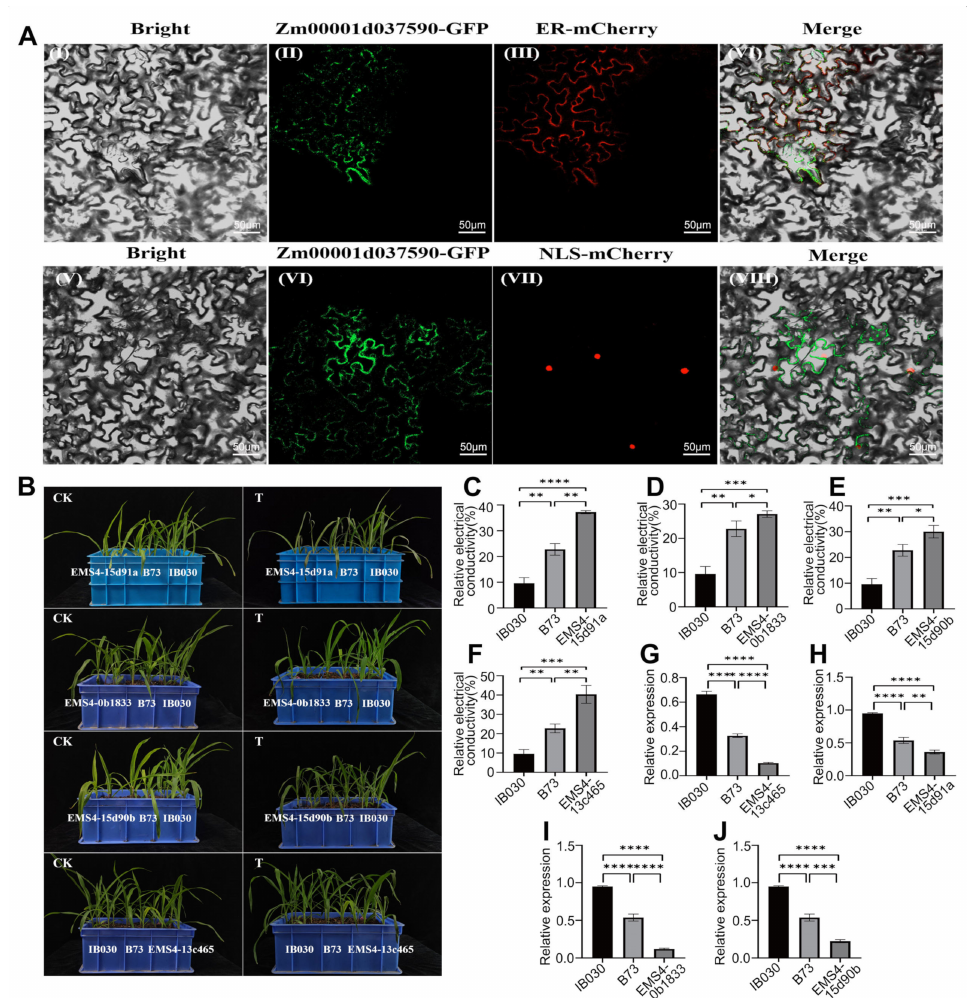
Figure 6. ( A ) Subcellular localization of Zm00001d037590 protein. I and V were bright fields; II and VI were Zm00001d037590 -GFP; III and VII were ER-mCherry marker and NLS-mCherry marker, respectively; IV was the green fluorescence of Zm00001d037590-GFP fusion protein, which coincides with the red fluorescence of ER-mCherry; VIII was green fluorescence of Zm00001d037590-GFP fusion protein, which did not coincide with the red fluorescence of NLS-mCherry. ( B ) Growth status of wild-type B73, EMS single-base mutants, and MIL-IB030 before and after low-temperature stress. ( C )–( F ) REC of the leaves of wild-type B73, EMS single-base mutant, and MIL-IB030 after cold stress. ( G )–( J ) The relative expression of key candidate genes in wild-type B73, EMS single-base mutant, and MIL-IB030 under low-temperature stress. Note: EMS4-13c465 ( Zm00001d037590 ), EMS4-15d91a ( Zm00001d012321 ), EMS4-0b1833 ( Zm00001d012321 ), and EMS4-15d90b ( Zm00001d012321 ). * indicates significance at 0.05 level, ** indicates significance at 0.01 level, *** indicates significance at 0.001 level, and **** indicates significance at 0.0001